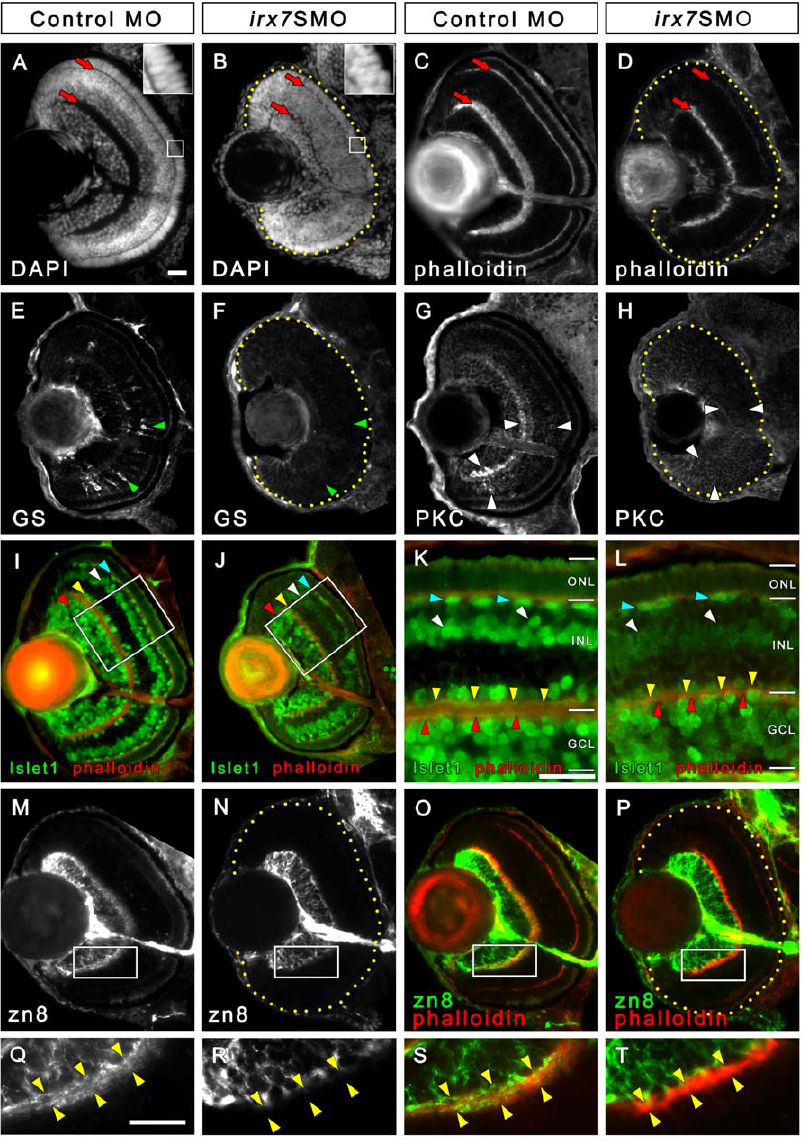
Figure 5. Irx7 knockdown reduces eye size and compromises retinal lamination, INL cells differentiation and dendritic projection of GCs into the INL. Irx7 knockdown reduced eye size and compromised retinal lamination at 72 hpf, as indicated by the DAPI (A and B) and phalloidin (C and D) stains that highlight nuclei and plexiform layers respectively. The red arrows indicate the IPL and OPL. The insets of (A) and (B) also show that the normal elongated morphology of the photoreceptors in control was compromised in the Irx7 morphant. The INL cells differentiation was analyzed by anti-GS for MCs (E and F), anti-PKC for BCs (G and H) and anti-Islet1 for ACs, BCs and HCs (I–L) at the same stage. Irx7 knockdown did not decrease the zn8 + GCs (N) compared with the controls (M), except for the elimination of a fuzzy domain on the apical side of the GCL (compare Q and R). This domain likely represents the dendritic projections of the GCs into the IPL, as it overlapped with the phalloidin staining of the IPL substantially (O and S). This overlap was completely absent in the morphants (P and T). Lateral is to the left and dorsal is up for all sections, except for (K and L), in which the apical side of retina is up. In addition, the retinal region in the samples with weak signal is highlighted by a dotted yellow line. The features indicated by the arrowheads are further discussed in the text. Scale bars=20 m